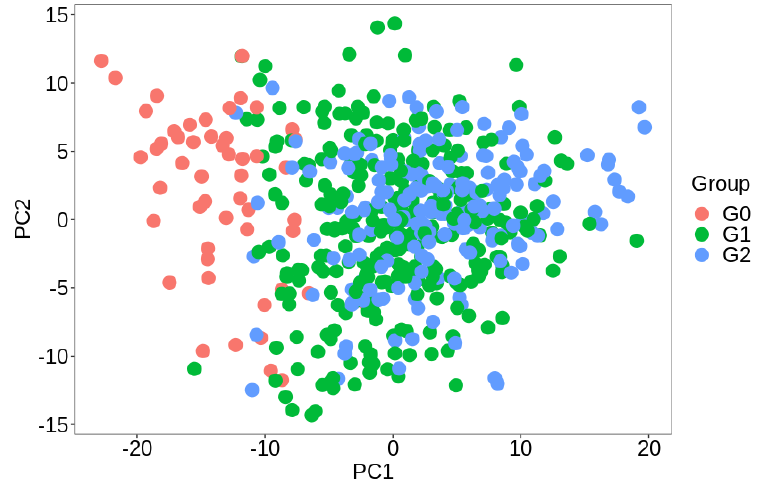
Figure 1. PCA plot representing G0, G1, and G2 TCGA data.